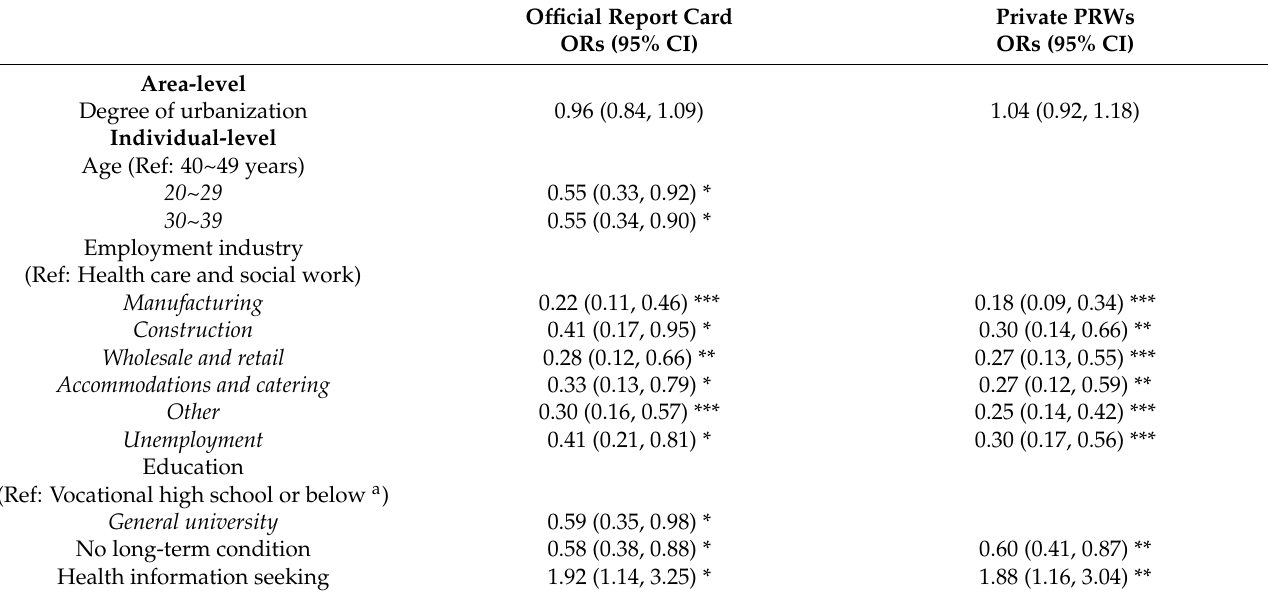
Table 2. Factors related to awareness of official report cards or private PRWs ( n =